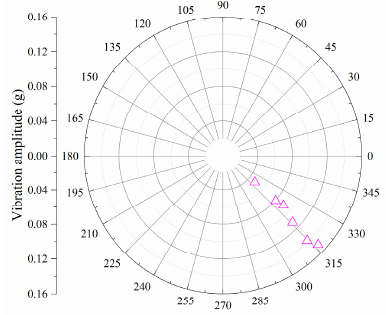
Figure 14. Longitudinal polar diagram of counterweight.